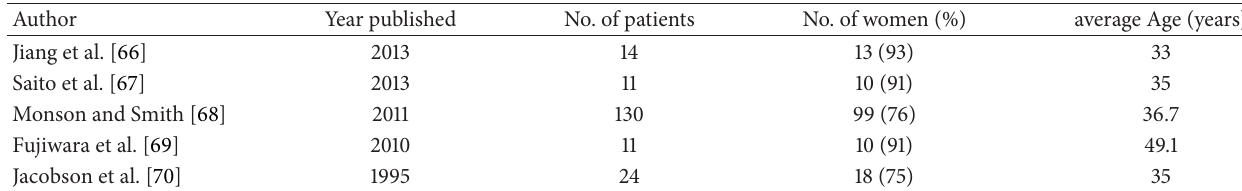
Table 6: Reports for acute zonal occult outer